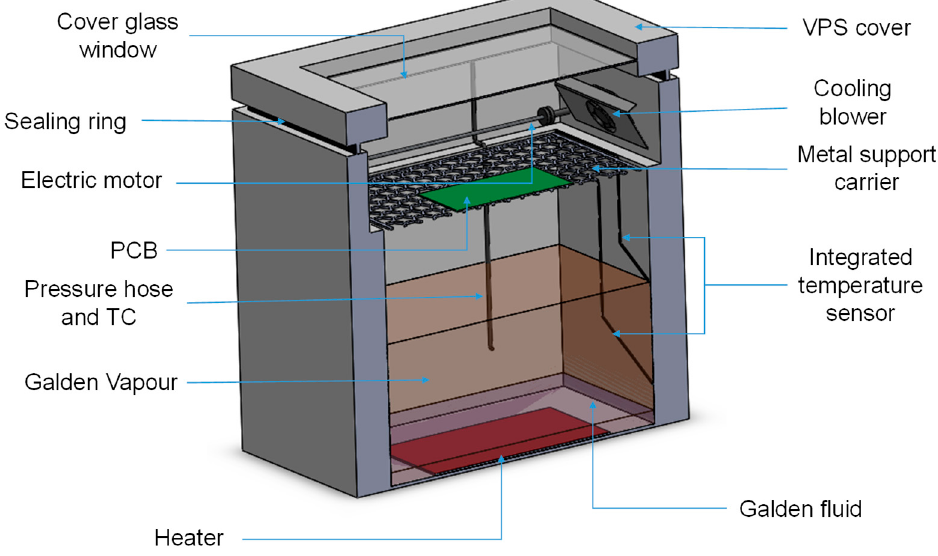
Figure 4. 3D model of the experimental setup.